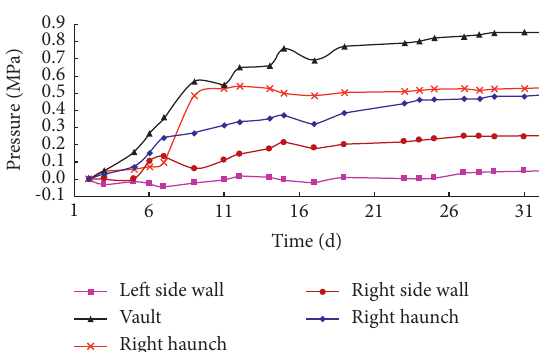
Figure 12: Law of variation in pressure of the surrounding rock in typical cross-section tunnel with time.